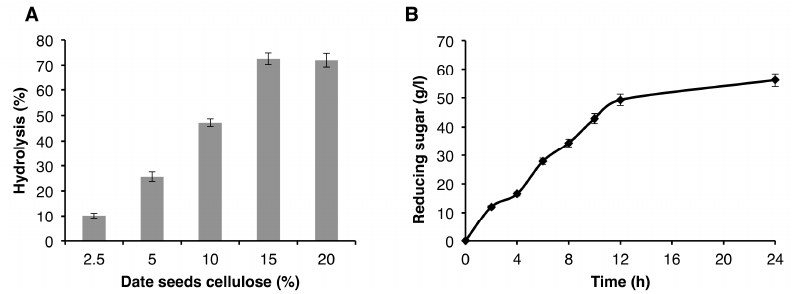
Figure 5. ( A ) Optimization of date seed cellulose percentage. ( B ) Hydrolysis kinetic of date seed cellulose.